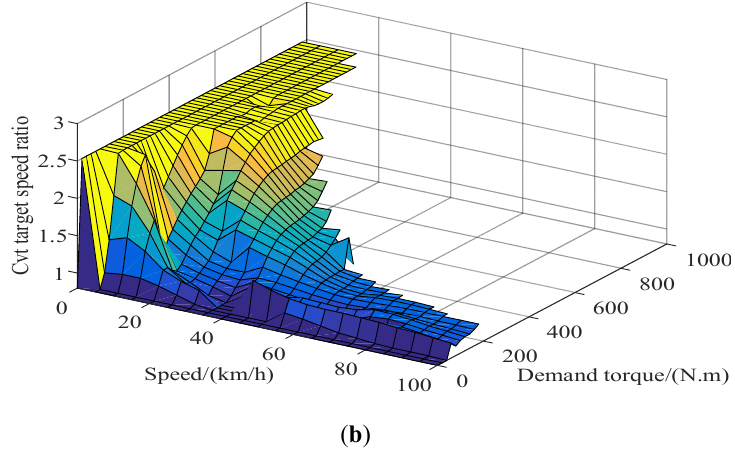
Figure 8. Optimization results in the purely electric mode: ( a ) target torque of motor; ( b ) target speed ratio of continuously variable transmission (CVT).